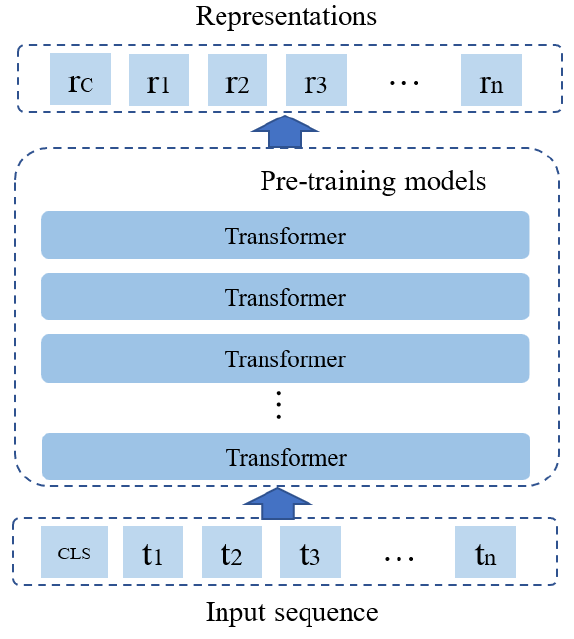
Figure 2. The typical structure of a pre-training model in the field of NLP.